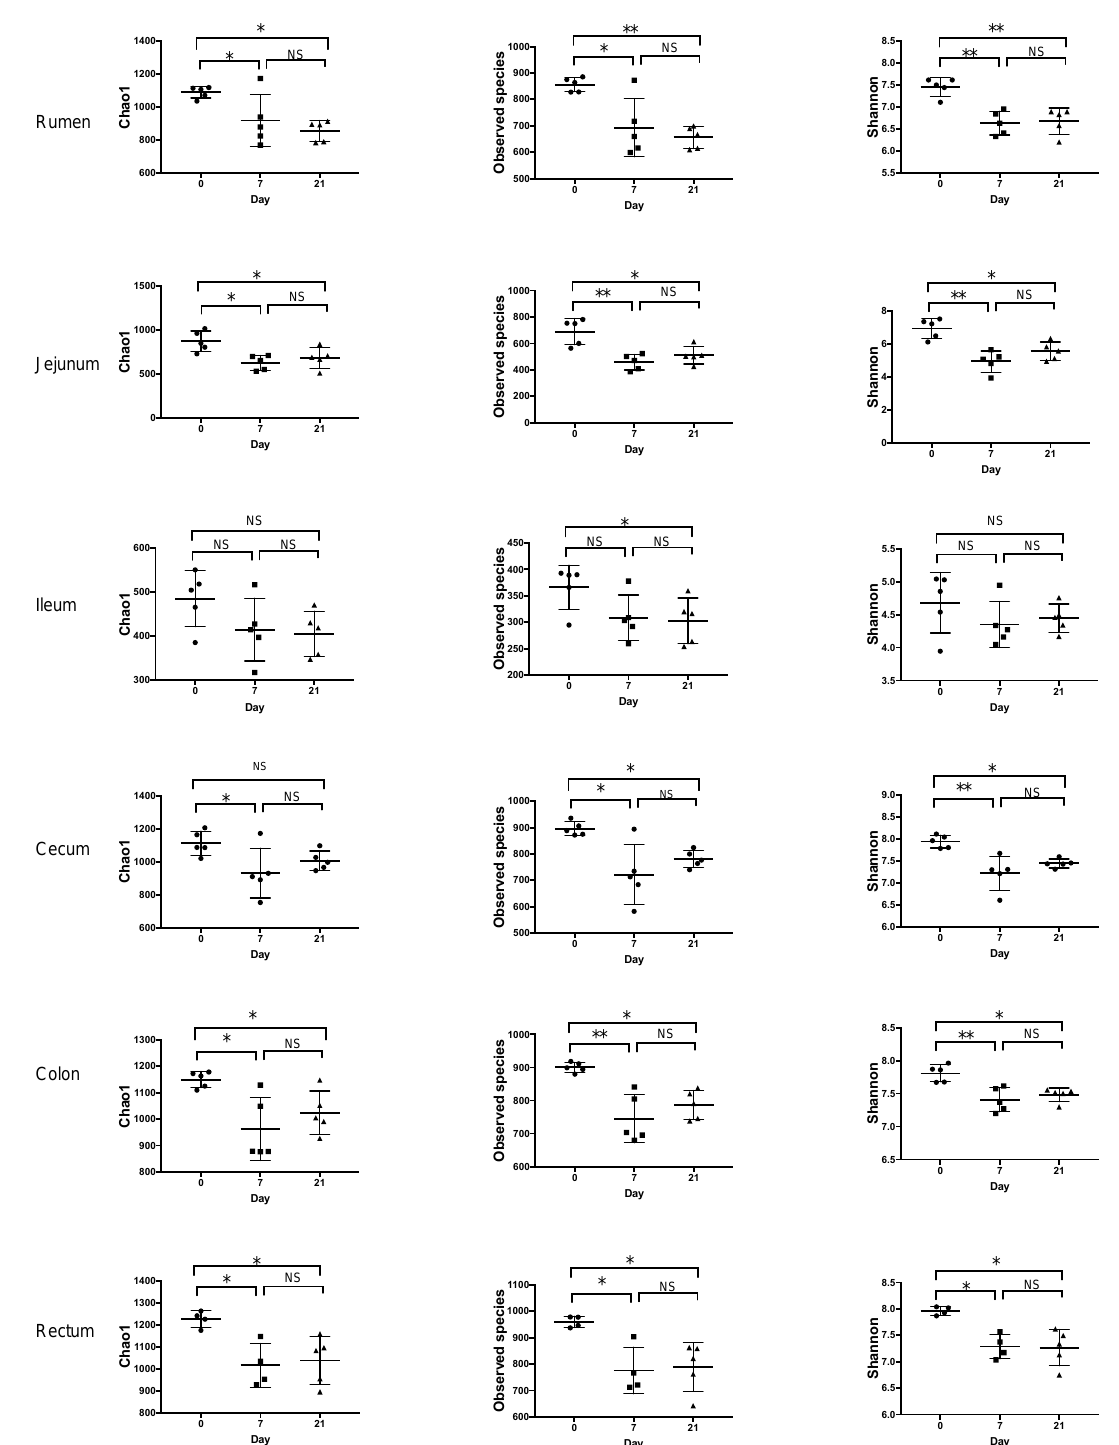
Figure 2. Effect of feeding a moderately-high grain diet on the alpha-diversity of microbiota by region of the digestive tract. Day 0 = no grain feeding, Day 7 = moderate grain feeding for 7 d, Day 21 = moderate grain feeding for 21 d. * = significantly ( p < 0.05) different, ** = significantly ( p < 0.01) different, NS = not significantly different.